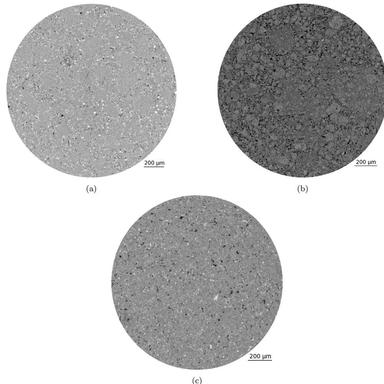
X-ray micro-CT images of samples made of: (a) material 1 (commercial samples), (b) material 2 (in-house prepared samples sintered at 1400◦C) and (c) material 3 (in-house prepared samples sintered at 1500◦C).